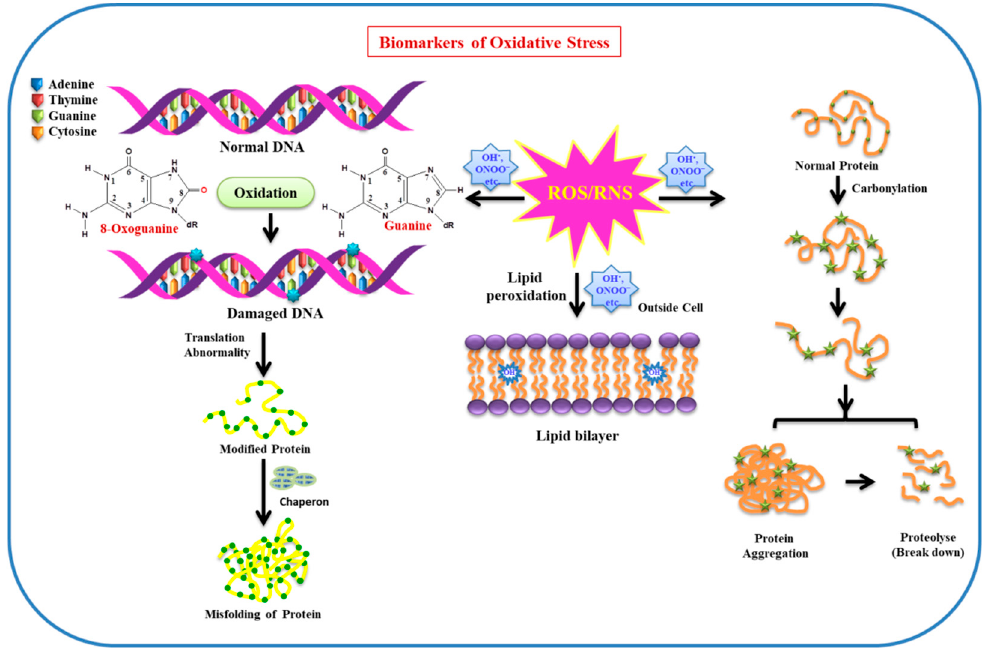
Figure 2. Effect of ROS/RNS on biomolecules (DNA, protein, lipid, etc.) used as biomarkers of oxidative stress in cellular environment.